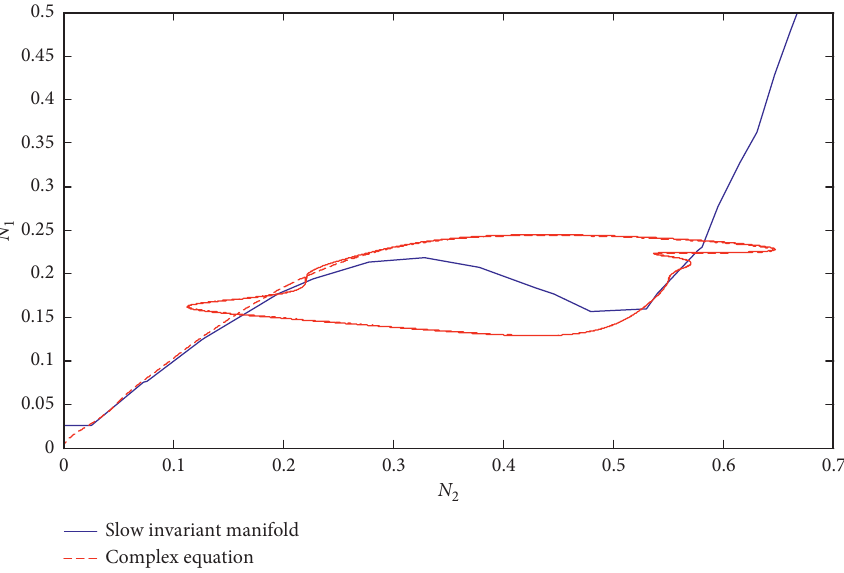
Figure 4: Slow invariant manifold for the case λ